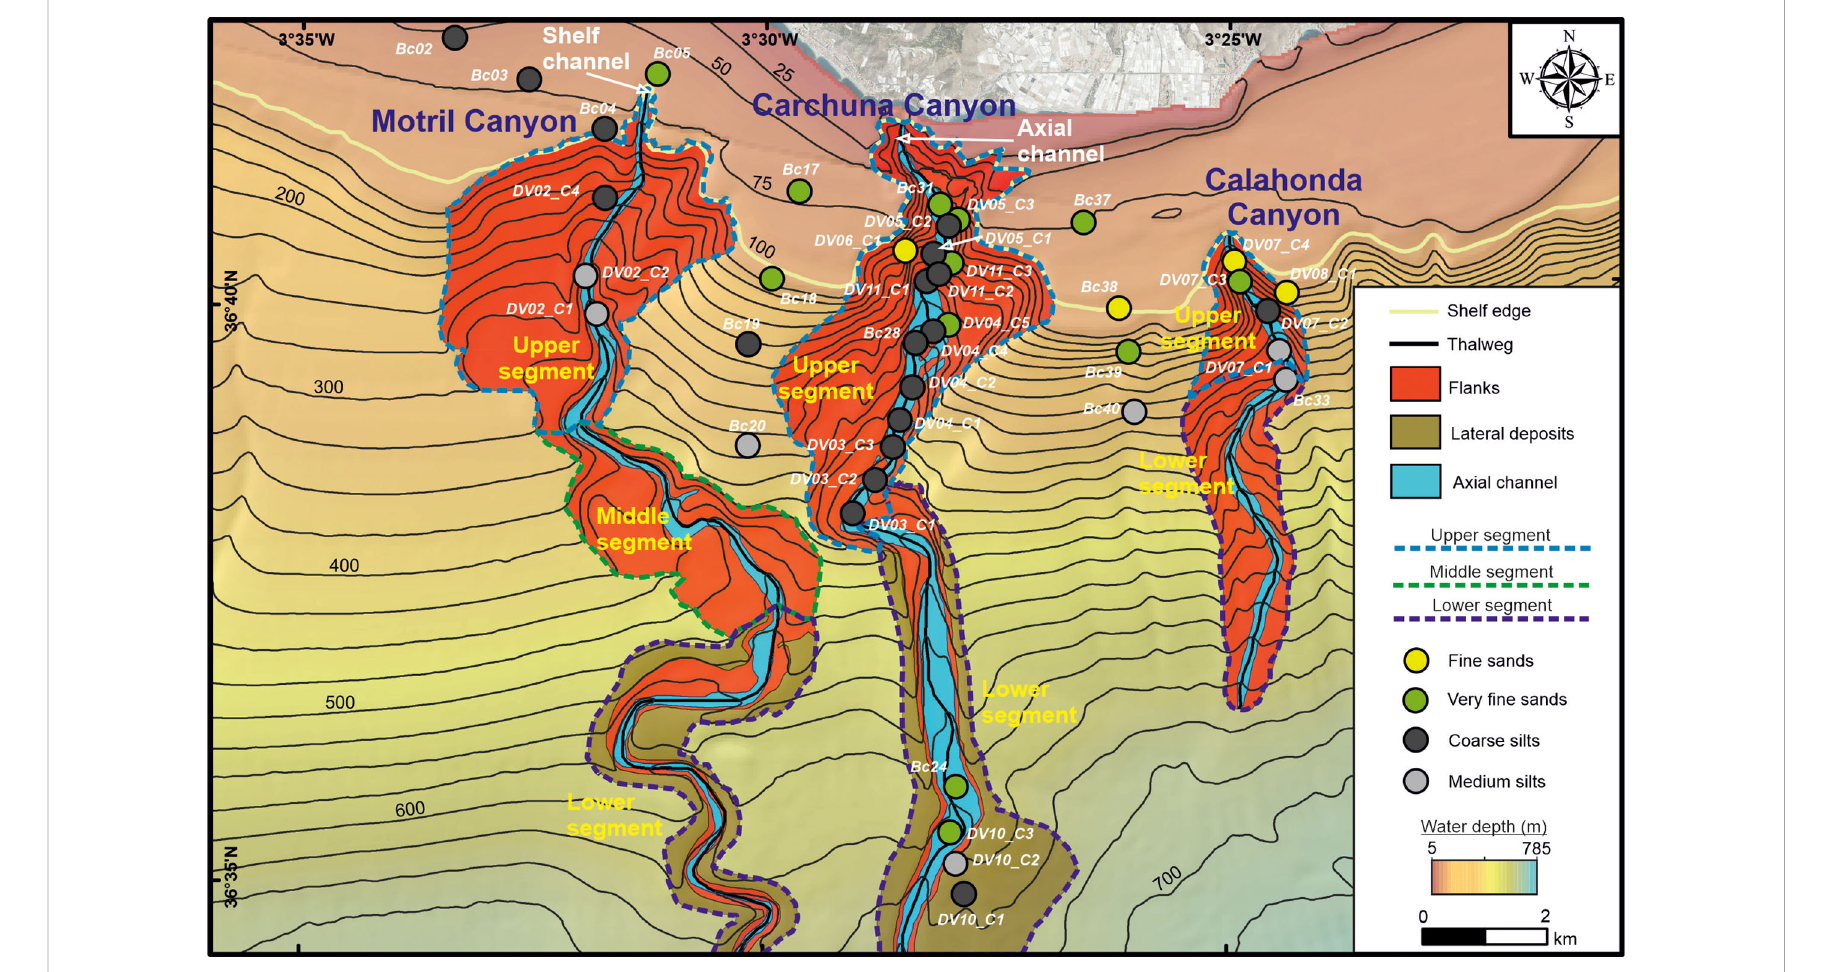
FIGURE 2 Geomorphologic map of the Motril, Carchuna and Calahonda submarine canyons showing the segment distribution within each canyon and the texture of sur fi cial sediment samples. Bathymetric contours in meters. See Supplementary Table 1 in which location and depth of the sediment cores sampled for grain size analysis are